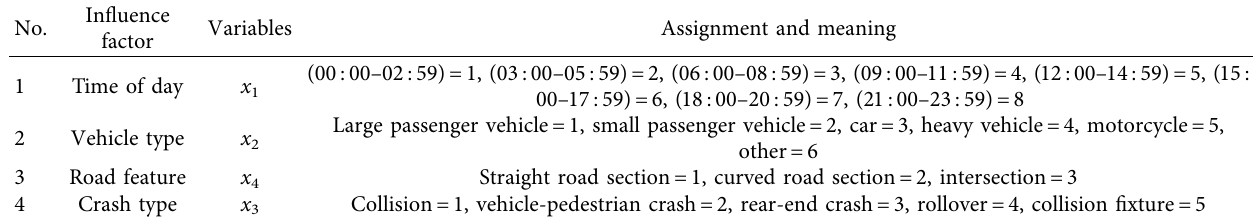
Table 3: Variable